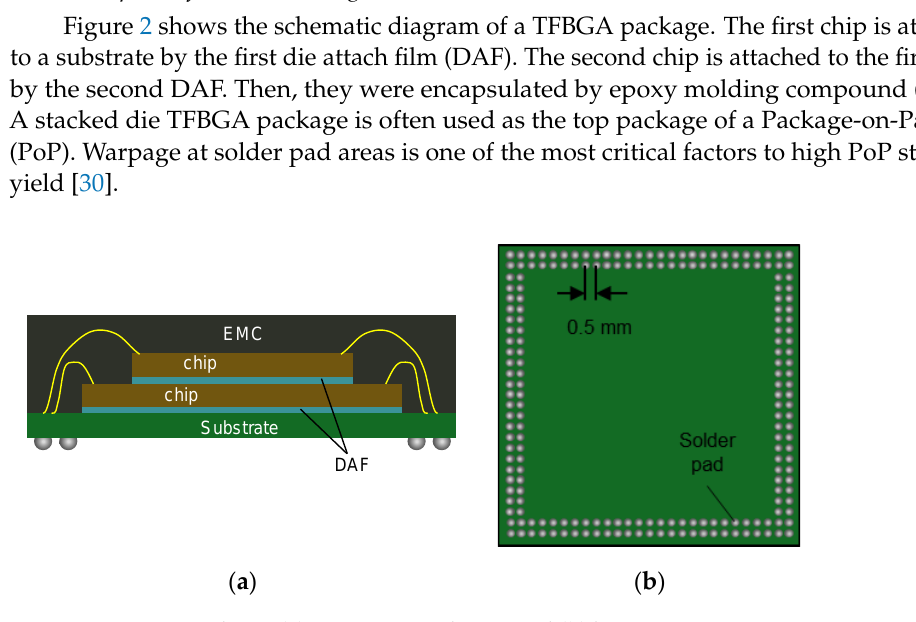
( b ) ( c ) Figure 3. Quarter FE model of TFBGA package: ( a ) boundary conditions; ( b ) die stack configuration; and ( c ) enlarged view of cross-section. The TFBGA package was subjected to the EMC molding process at 175 °C, which was used as a stress-free temperature. The conventional lead-free solder reflow profile with the peak temperature of 260 °C was considered [32]. In this implementation, 10 design variables were considered for the warpage predic- tion of solder pad areas. The details of design variables are summarized in Table 3. The design spaces of the package dimensions and the material properties were defined by the values found in the literature: package dimensions in [31,33–39] and material properties in [40–45].